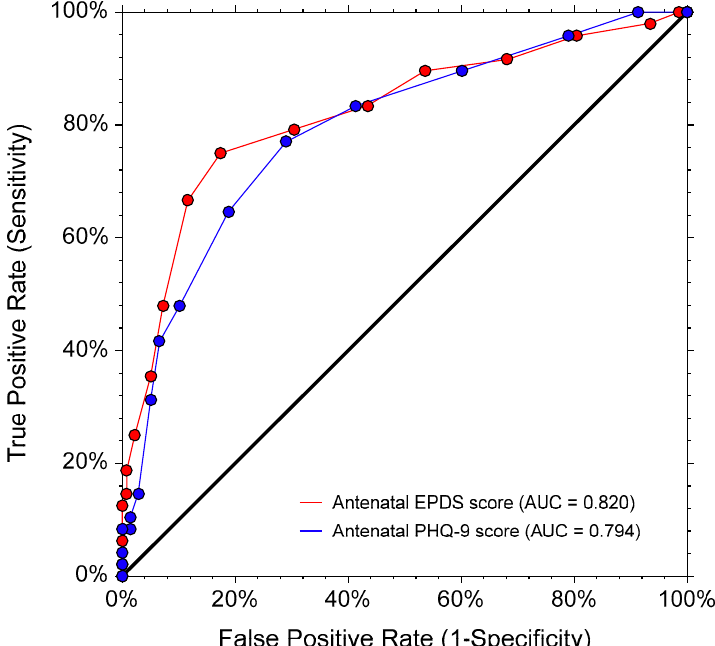
Figure 2. The receiver operating characteristic (ROC) curves of EPDS and PHQ-9 scores to differentiate disability (WHODAS score ≥ 10) from non-disability in 186 pregnant women (antenatal data only). AUC (95% CI; p -value): EPDS score = 0.82 (0.73, 0.88; p < 0.001), PHQ-9 score = 0.79 (0.71, 0.86; p < 0.01). AUC difference (95% CI; p -value): 0.03 ( − 0.05, 0.10; p = 0.513). AUC, area under the (receiver operating) curve (empirical estimate); EPDS, Edinburgh Postnatal Depression Scale; PHQ9, 9-item Patient Health Questionnaire; WHODAS, 12-item World Health Organization Disability Assessment